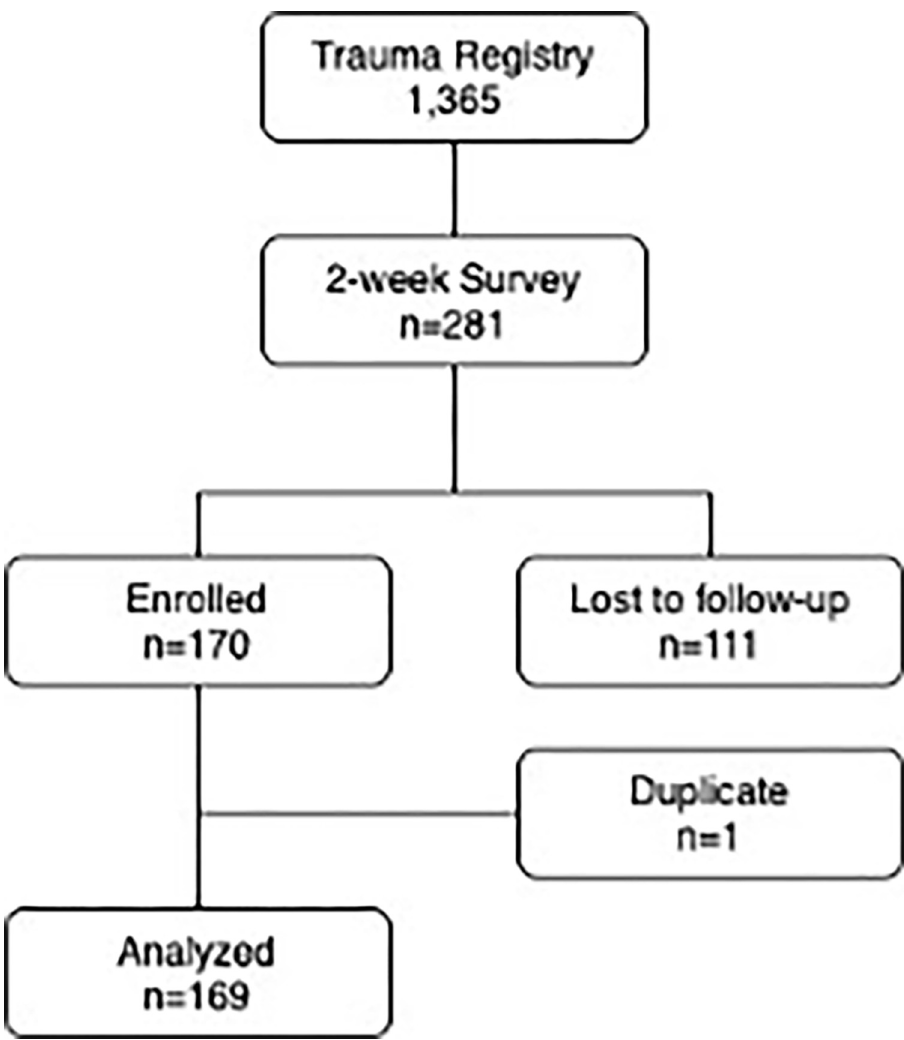
Fig 2. Enrollment flow